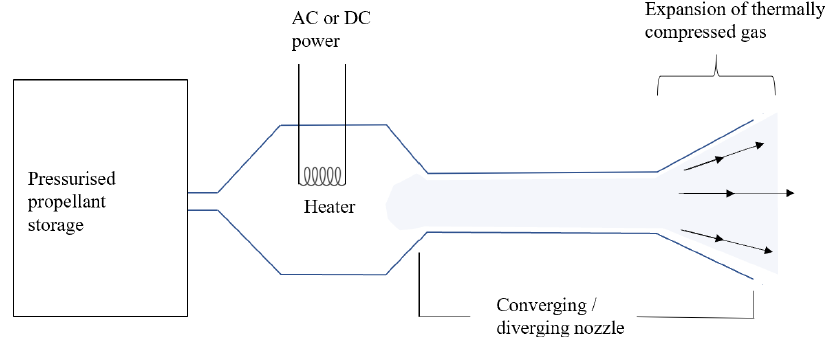
Figure 9. A resistojet thruster as a simplified schematic